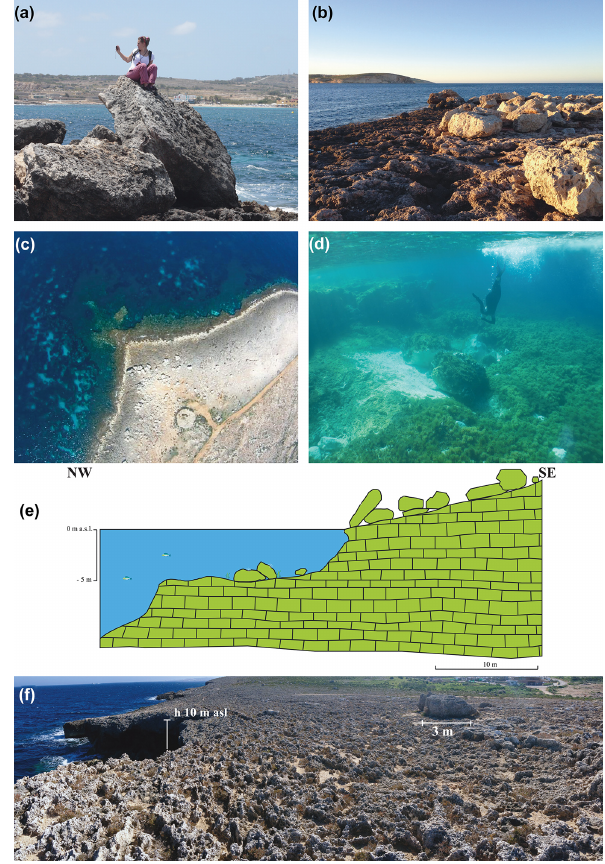
Figure 3. (a) Boulder AB1 at Armier Bay; (b) boulder deposit at Armier Bay; (c) view of the Armier Bay boulder deposit from a UAV (unmanned aerial vehicle); (d) submerged isolated boulders; (e) reconstruction of the submerged environment at Armier Bay; (f) cliff top storm deposits at Ahrax